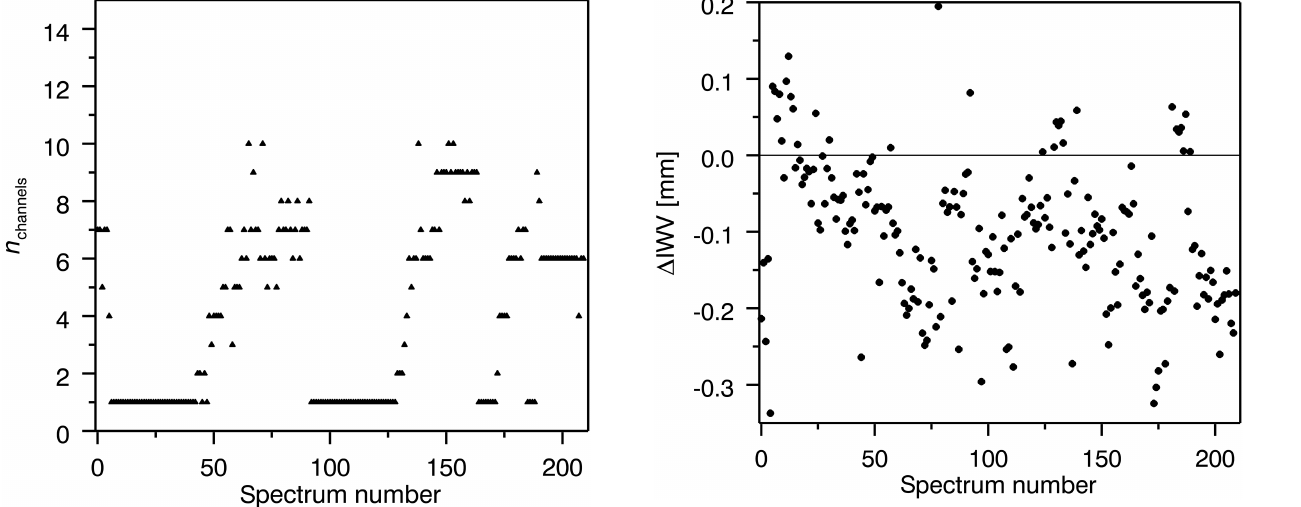
Figure A2. Number of spectral channels included in the IWV fit for the spectra of the FIR continuum data set. n channels was chosen according to the minimum uncertainty criterion shown in Fig. A1.